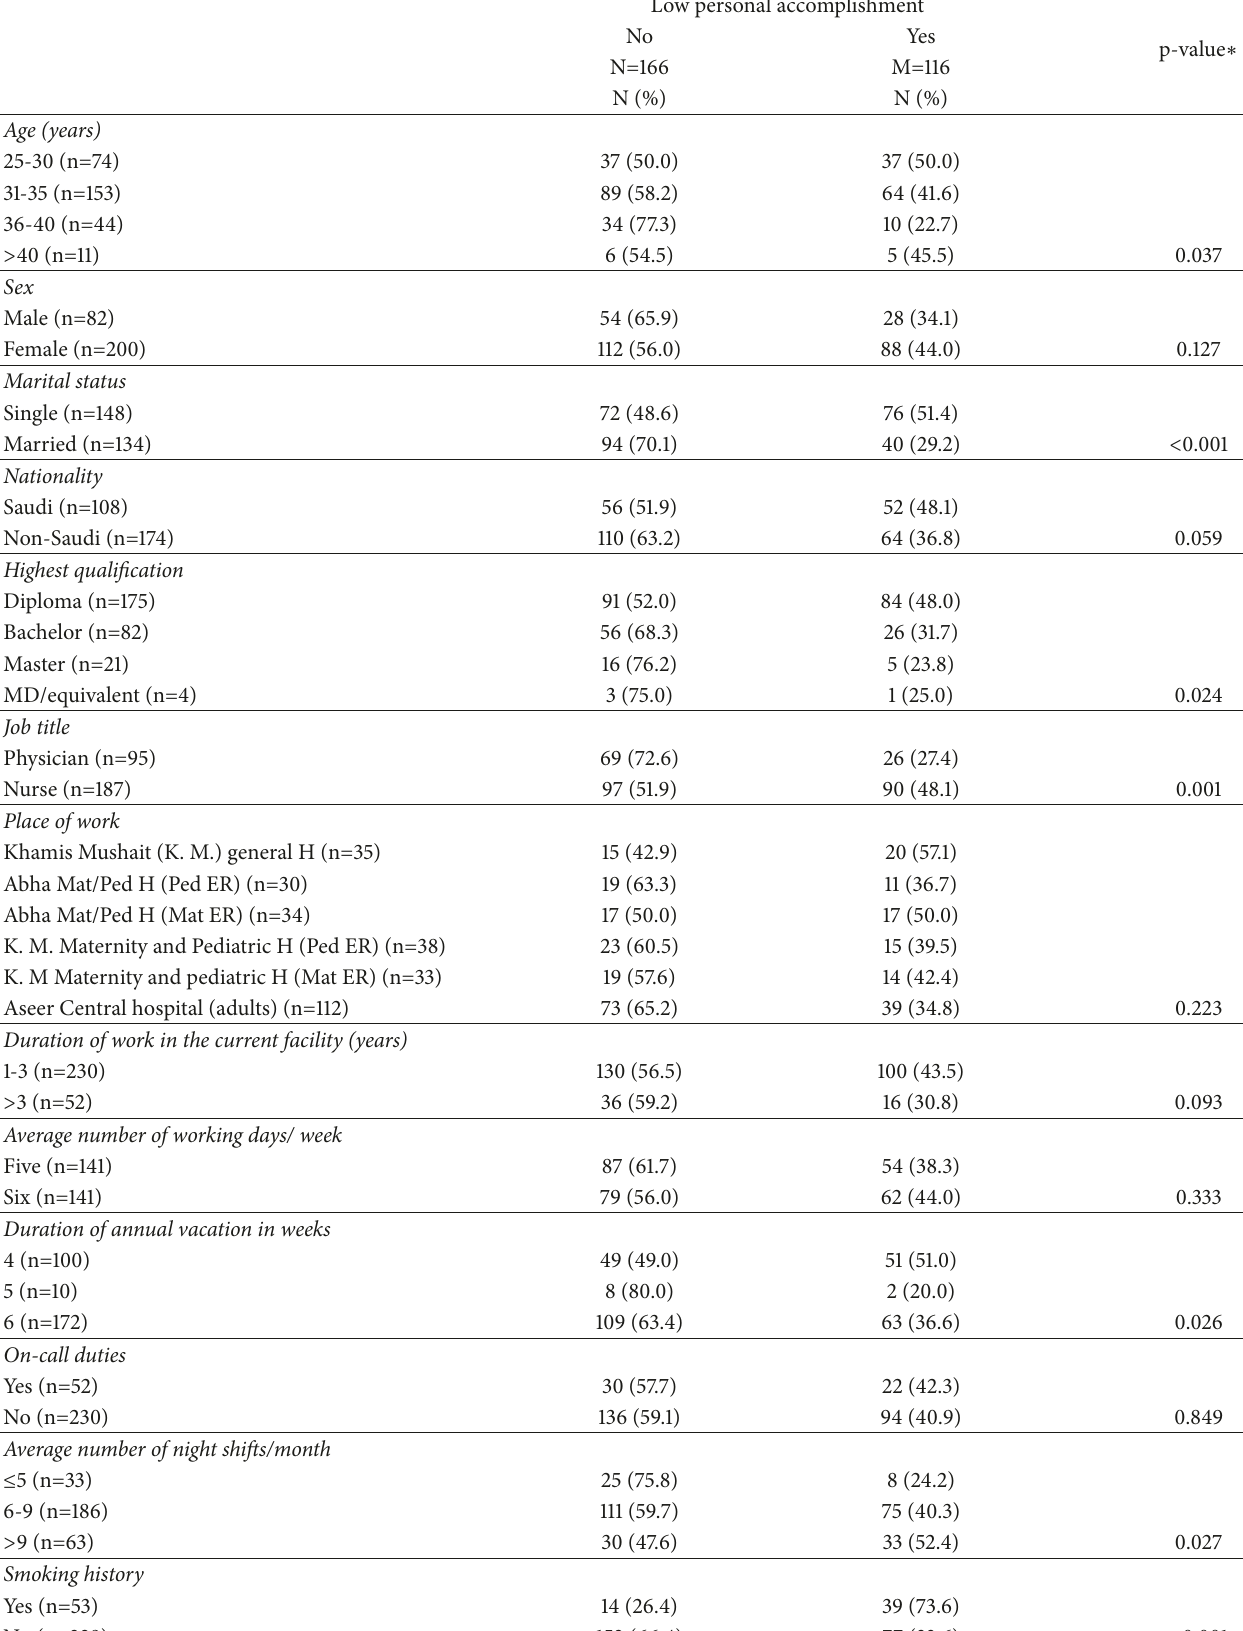
Table 5: Factors associated with low personal accomplishment among emergency healthcare